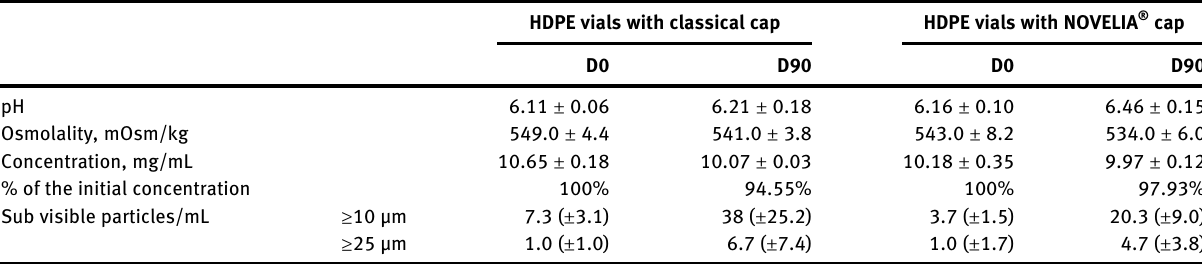
Table  : PhysicochemicalandsubvisibleparticlescountresultsofeyedropsolutionsatD  andD  daysinHDPEvialswithclassicalcapand vials with Novelia ®